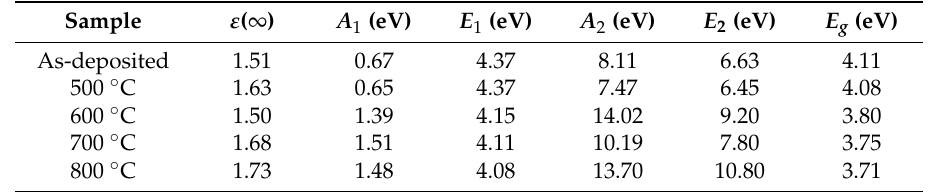
Table 2. Main parameters ( ε ( ∞ ) , A i and E i ) of the Lorentz oscillator model and the calculated band gap E g for SrTiO 3 thin films annealed at different temperatures.